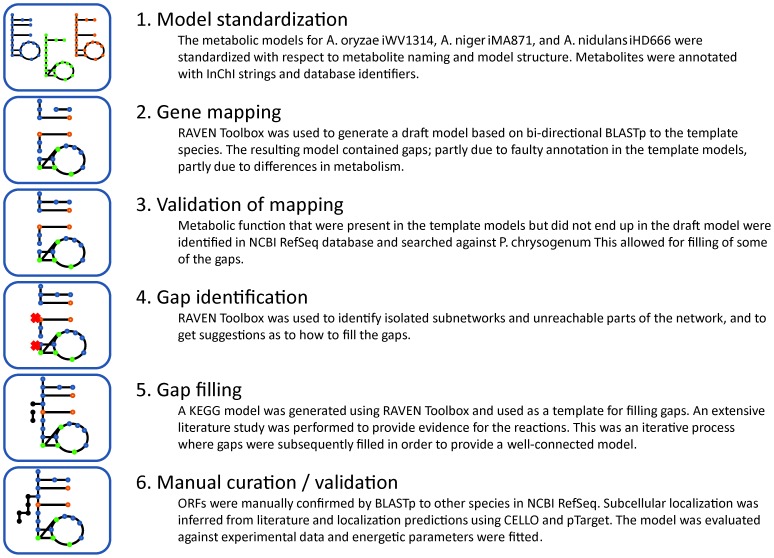
Overview of the iAL1006 reconstruction process.